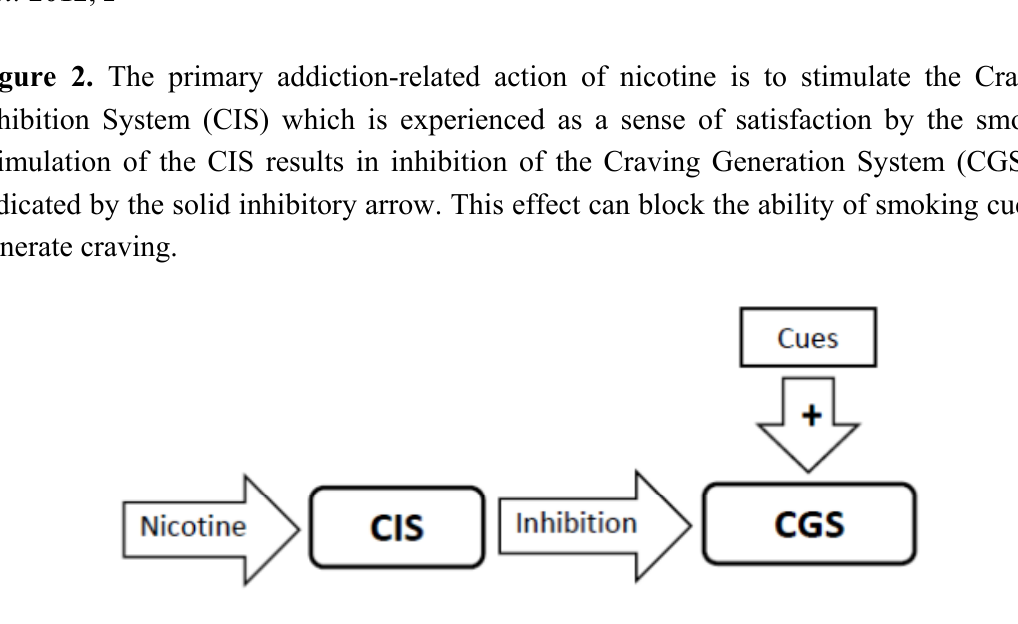
Figure 2. The primary addiction-related action of nicotine is to stimulate the Craving Inhibition System (CIS) which is experienced as a sense of satisfaction by the